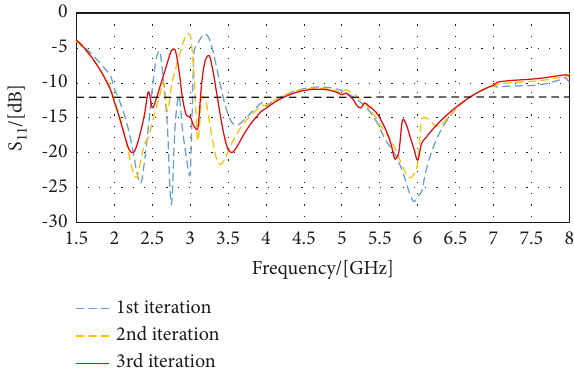
Figure 6: S11 comparison diagram of antenna iteration.